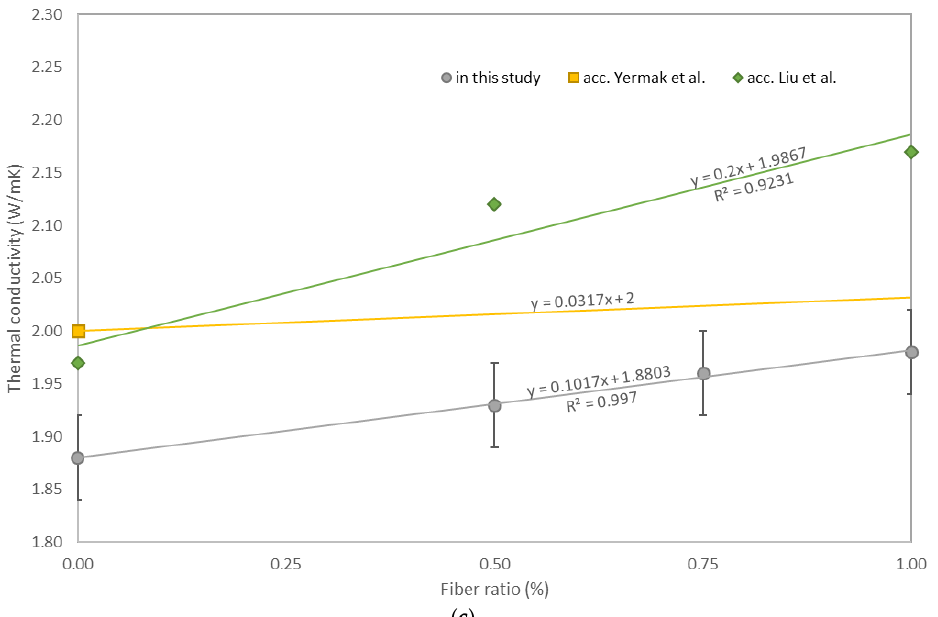
Figure 6. Thermal conductivity test results: ( a ) glass fiber concretes; ( b ) polypropylene fiber concretes; ( c ) steel fiber concretes.